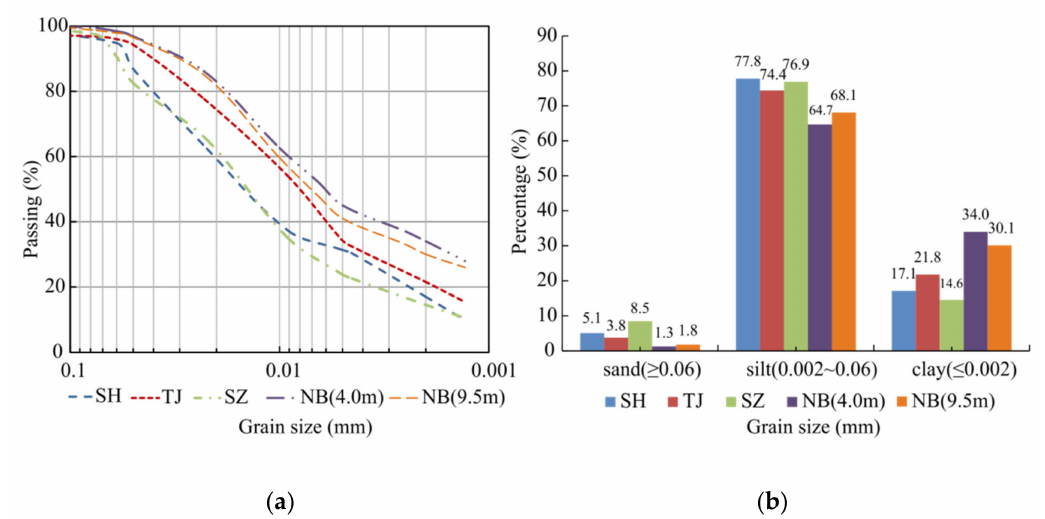
Figure 2. Grain composition of soft soils: ( a ) grain size distribution curves; ( b ) percentage of mineral fractions.